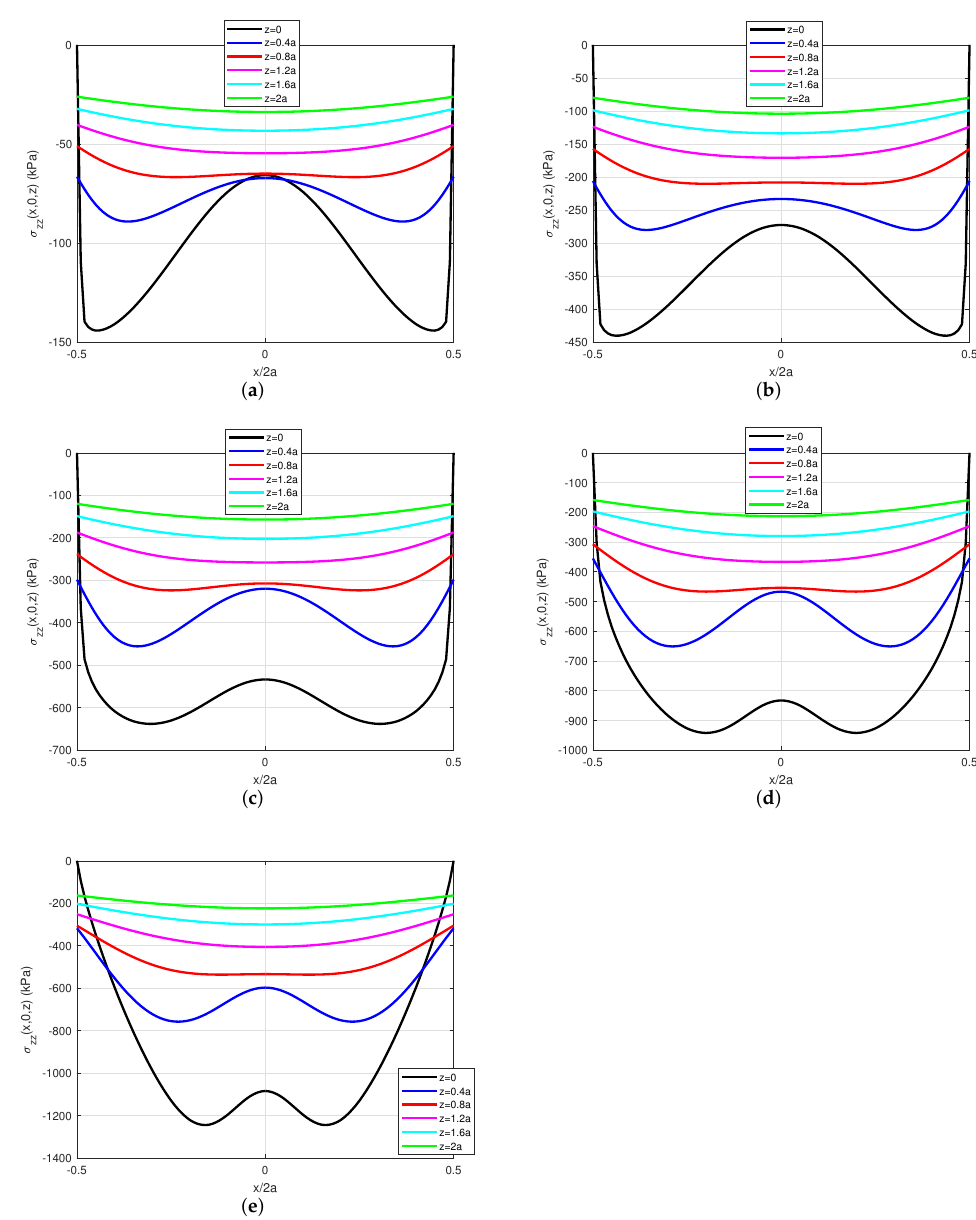
Figure 13. Vertical compressive stress σ zz in central cross sections with depth: ( a ) Case N1-T0.6; ( b ) Case N2-T0.6; ( c ) Case N3-T0.6; ( d ) Case N4-T0.6; ( e ) Case